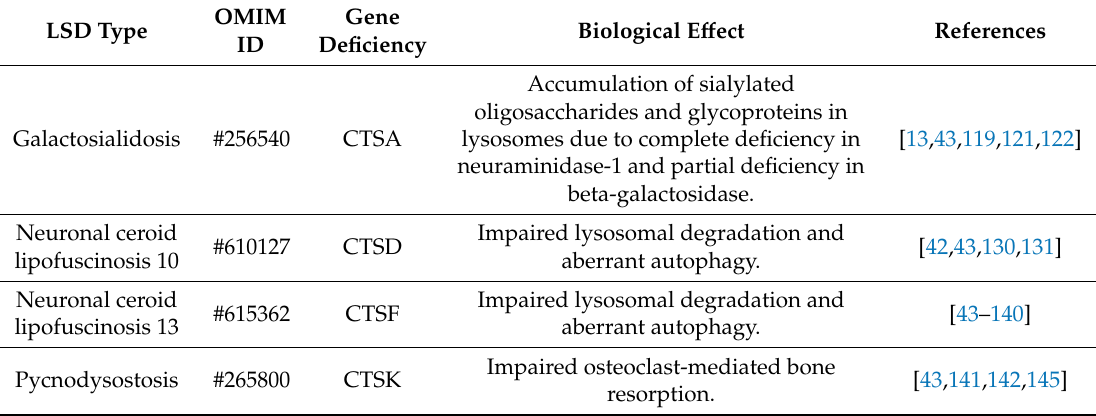
Table 2. Lysosomal storage diseases caused by cathepsin